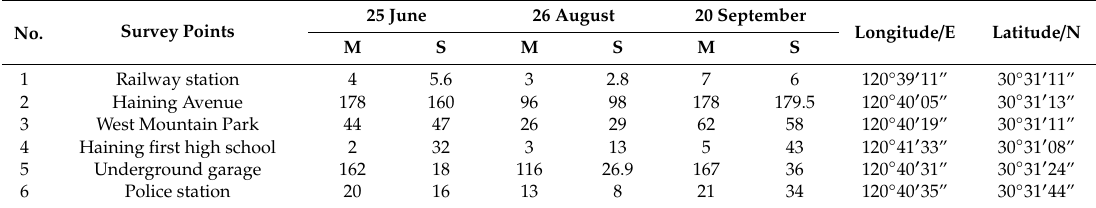
Table 1. Comparison of the simulated and measured inundation results of six sample data (Depth unit: mm).